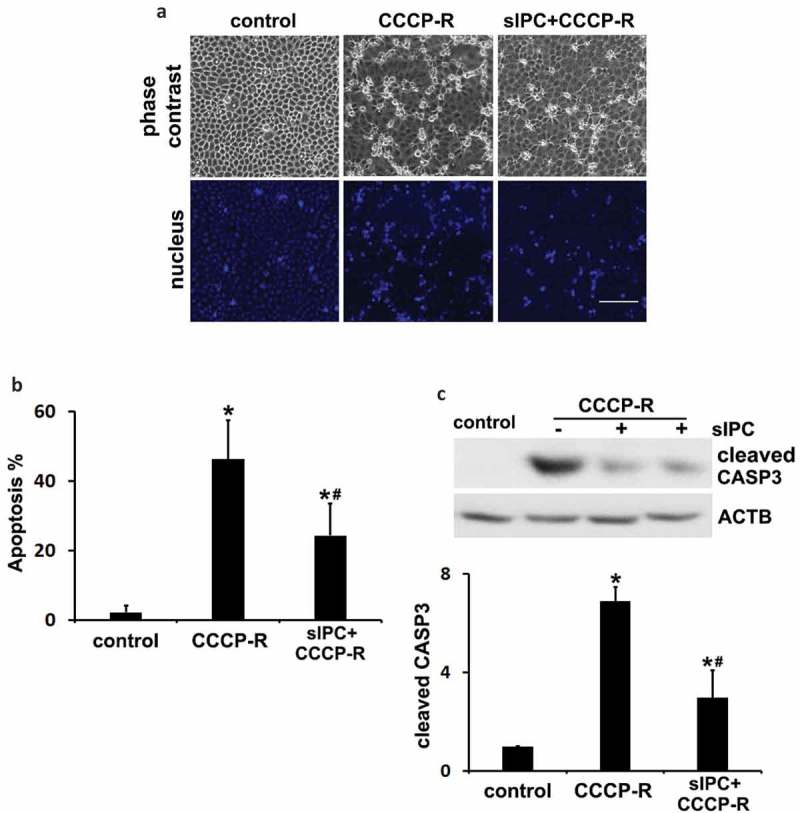
In vitro sIPC attenuates prolonged CCCP-induced apoptosis in RPTC cells. In vitro sIPC was induced by incubating RPTC cells with 20 μM CCCP for 30 min followed by 40 min of recovery. The cells were then treated with prolonged CCCP (20 μM) for 3 h followed by 2 h of recovery to model in vivo renal IRI. Cells were collected for analysis of apoptosis by morphology and caspase activation. (a) Representative images of phase contrast and fluorescence microscopy showing cellular and nuclear morphology of apoptosis. Scale bar: 200 μm. (b) Quantification of cell apoptosis. (c) Representative blots and densitometric analysis of cleaved CASP3. ACTB was used as a loading control. After normalization with ACTB, the protein signal of the control was arbitrarily set as 1, and the signals of other conditions were normalized to the control to calculate fold changes. Data in (b and c) are expressed as mean ± SD. *, P < 0.05, significantly different from the control group; #, P < 0.05, significantly different from CCCP-R group.